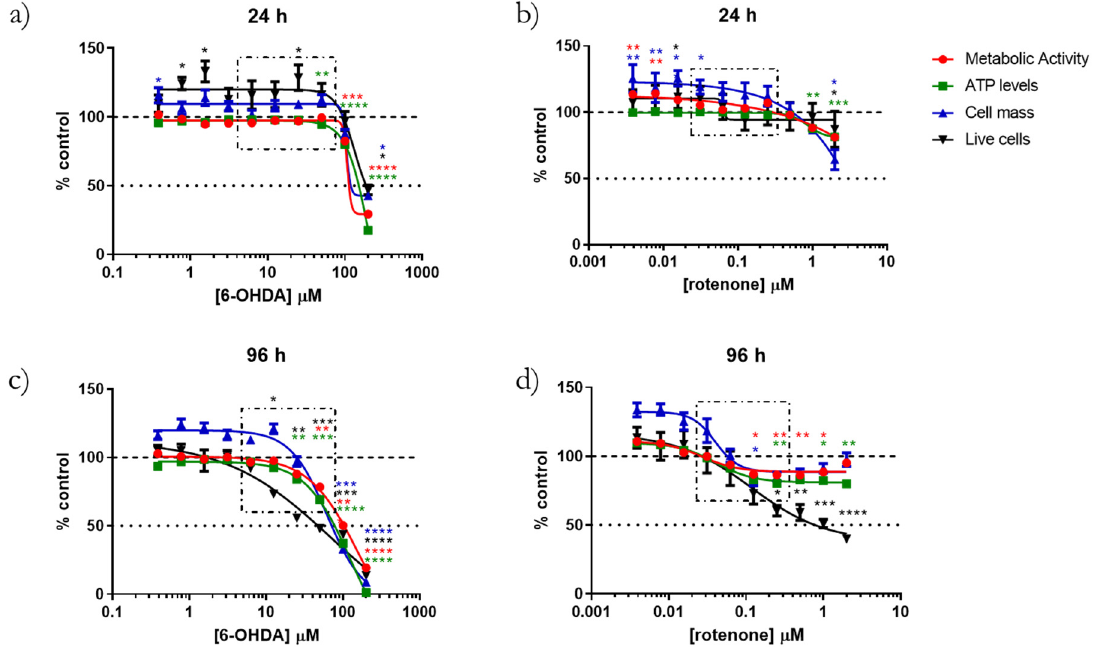
Figure 1. 6-OHDA and rotenone induced cytotoxicity in time- and dose-dependent manners. Dif- ferentiated SH-SY5Y cells were incubated with increasing concentrations of 6-OHDA or rotenone for 24 h ( a , b , respectively) or for 96 h ( c , d , respectively). Visible alterations in metabolic activity (in red), ATP levels (in green), SRB (in blue) and percentage of live cells (in black) were present in cells treated with both compounds. The compounds concentrations are displayed on the x-axis. Results are presented in percentage of control. Data are represented as Mean ± SEM and four-parameter logistic curves were adjusted to the data. Statistical significance was evaluated using Kruskal–Wallis test (One-way ANOVA on ranks) pairwise (control vs. 6-OHDA or control vs. rotenone), (*) p < 0.05, (**) p < 0.01, (***) p < 0.001 and (****) p < 0.0001.